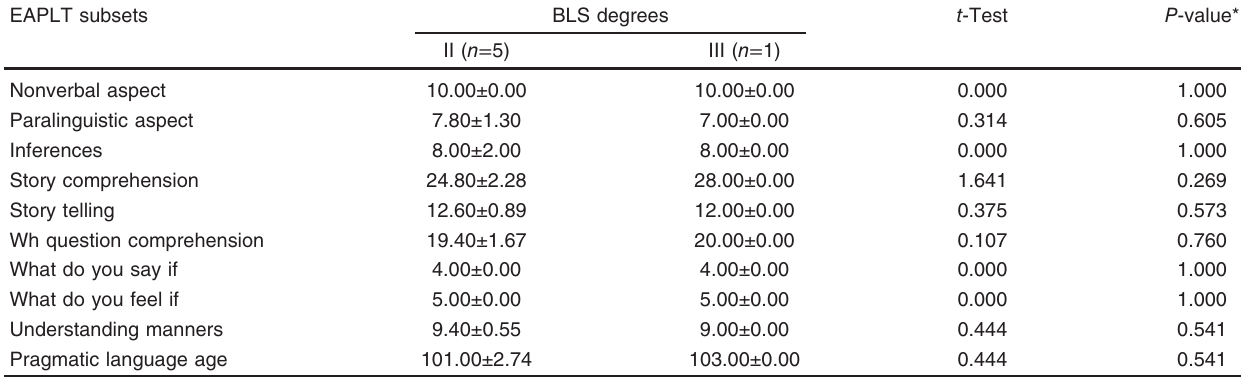
Table 8 Relation between stuttering severity measured by Bloodstein classification and pragmatic language development in children in age group I (4 years 1 month 1 day to 5 years 12 months 31 days) using independent sample t -test EAPLT